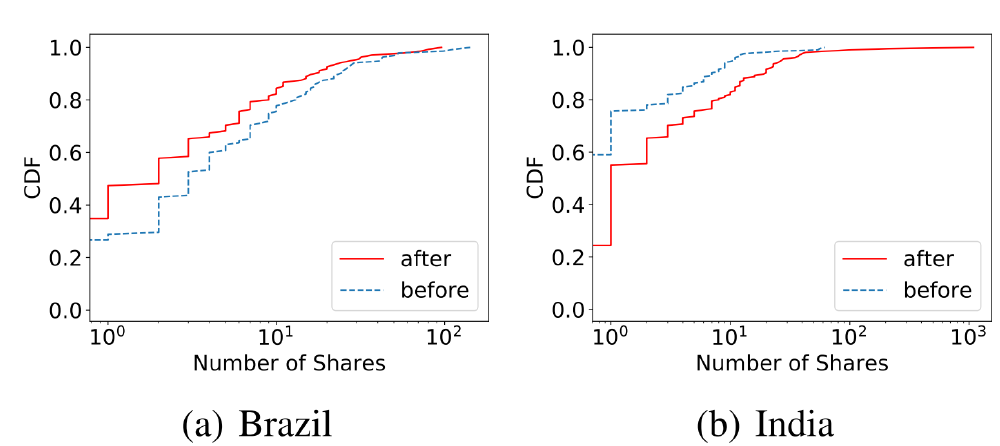
Figure 2. Cumulative distributions of shares of images containing misinformation before/after fact-checking on both countries.